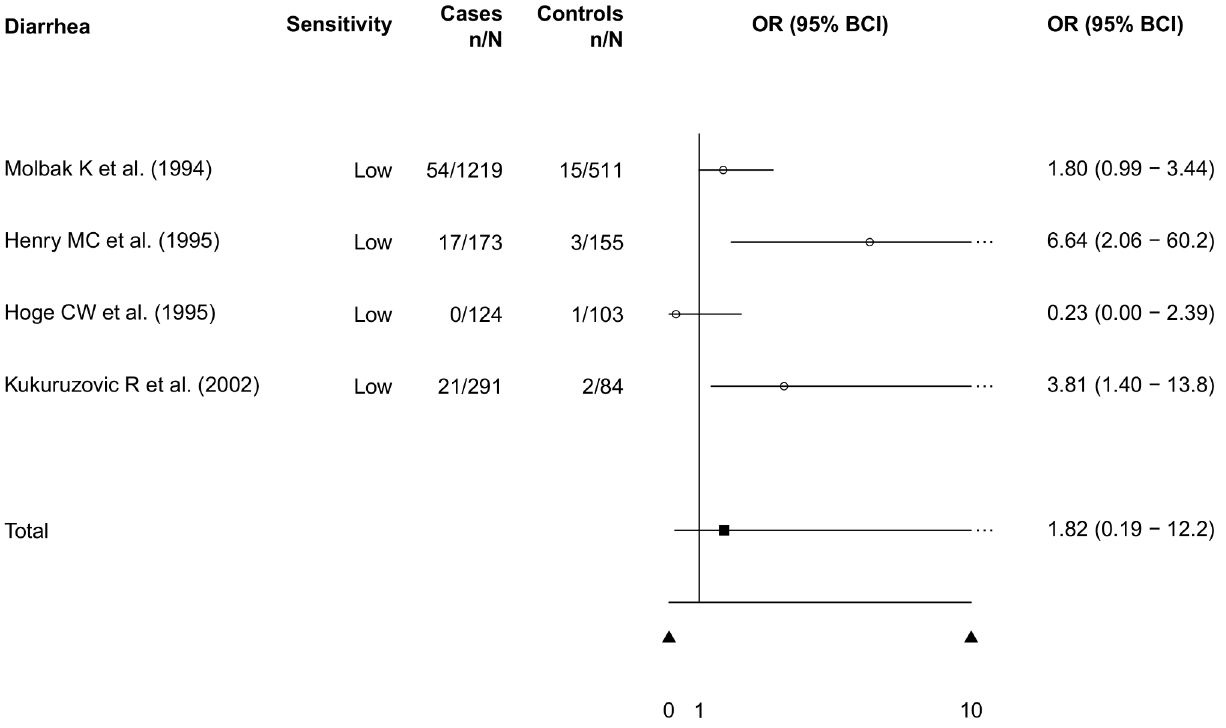
Figure 10. Risk of S.stercoralis infection in patients with diarrhea (meta-analysis of case-control studies).